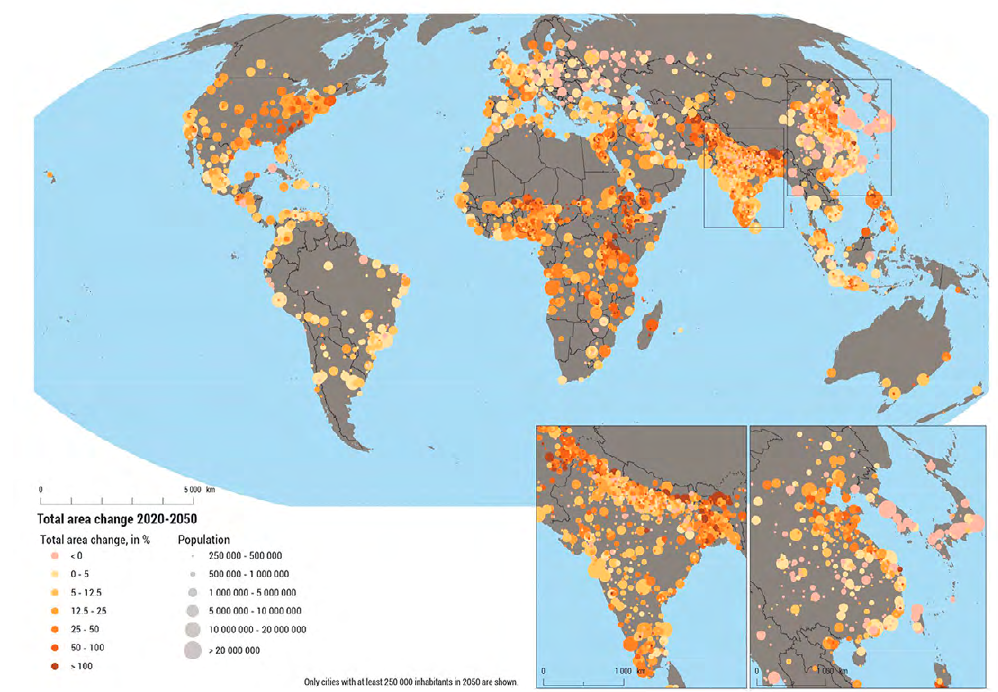
Figure 1. Projections of the urban area change (in %) and population in cities across the Globe for the period 2020-2050 Source: UN,